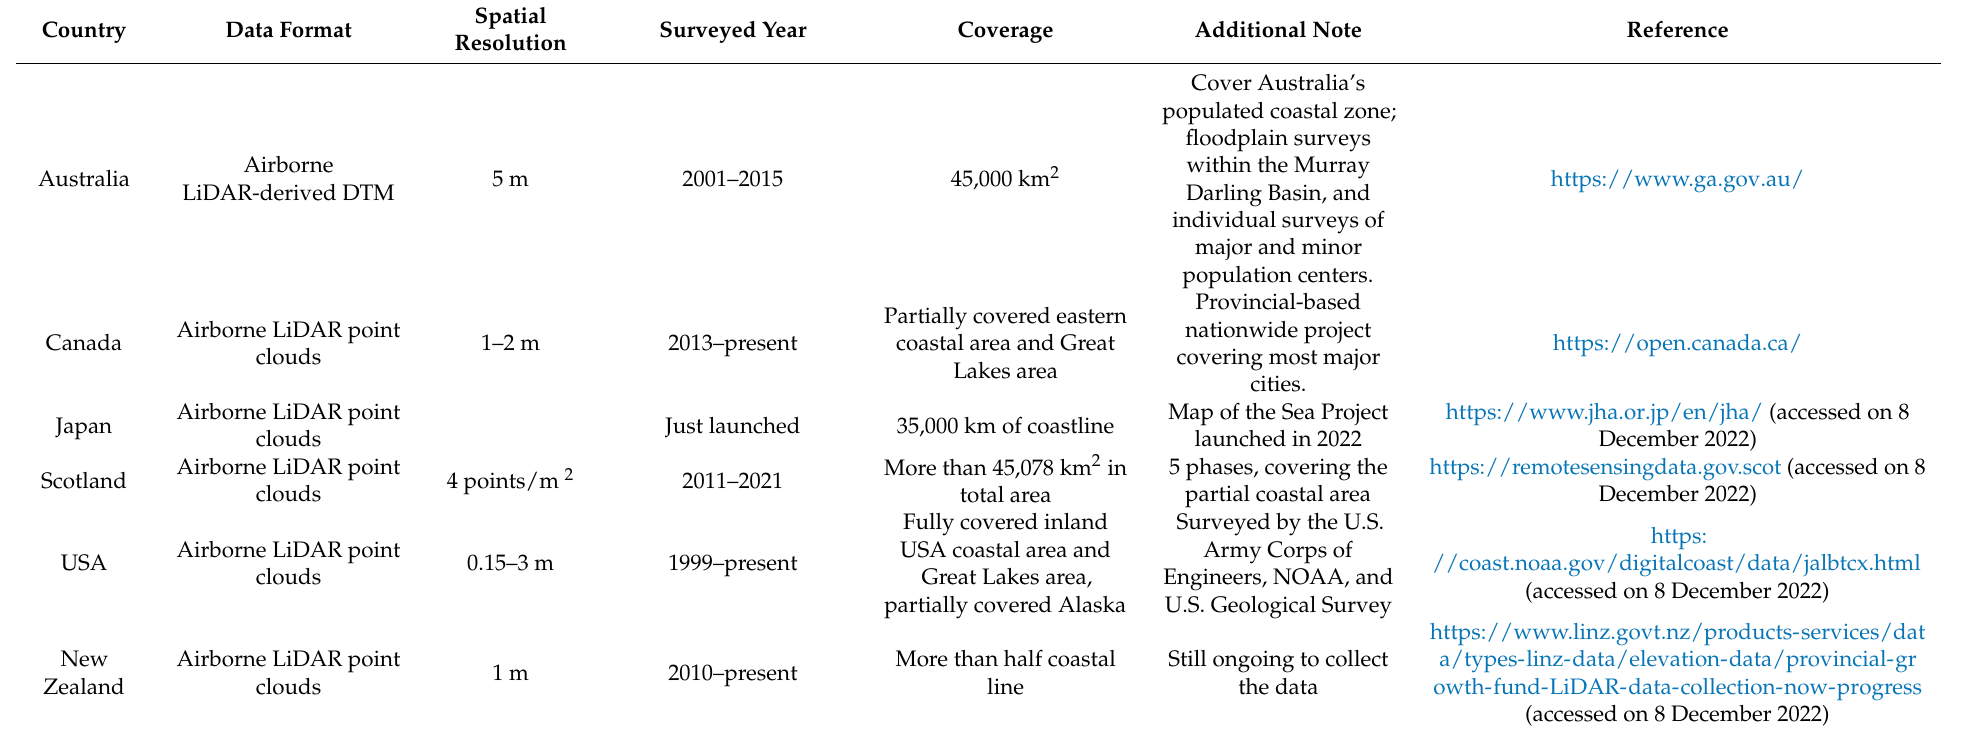
Table 4. A summary of available airborne LiDAR datasets in coastal